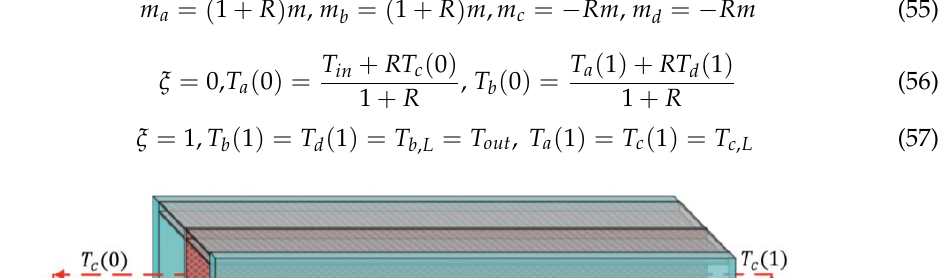
Table 1. Air mass flow rates of various configurations for Type A to Type D. . m a Left-Hand Side